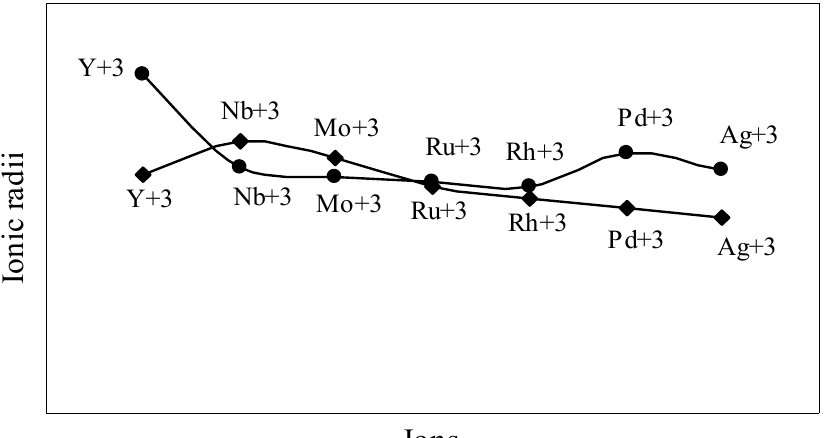
Figure 5. Plot of radii of tripositive ions of second transition series (4d-block) elements